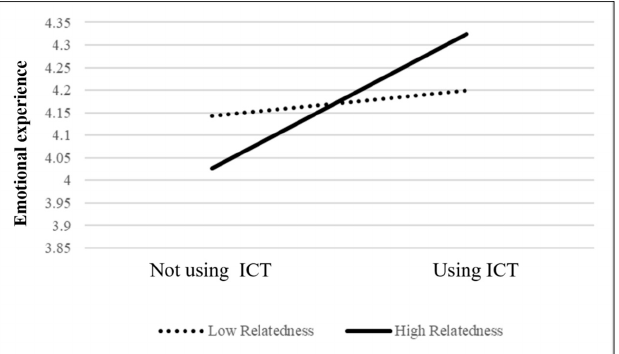
Figure 2. Moderating effect of ICT usage and relatedness on emotional experience.